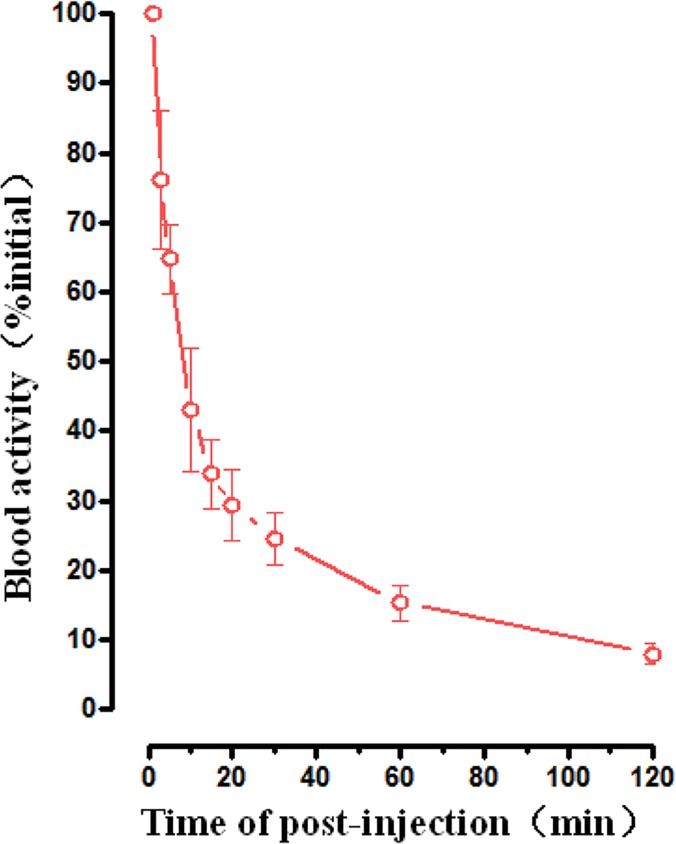
Averaged time-activity curve of 99mTc-RGD-BBN in blood for all healthy volunteers.Error bars indicate standard deviations.